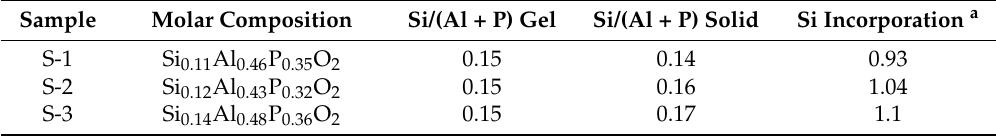
Table 6. The element composition and relative crystallinity of the sample with different templates.